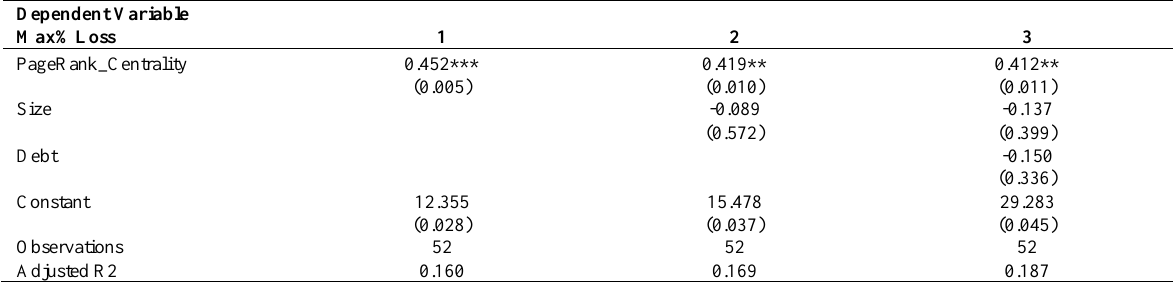
Table 4. Out-of-sample analysis. Parameter estimates of multivariate rank regression of Max%Loss as dependent variable and PageRank centrality as independent variable, size and leverage as control variables.